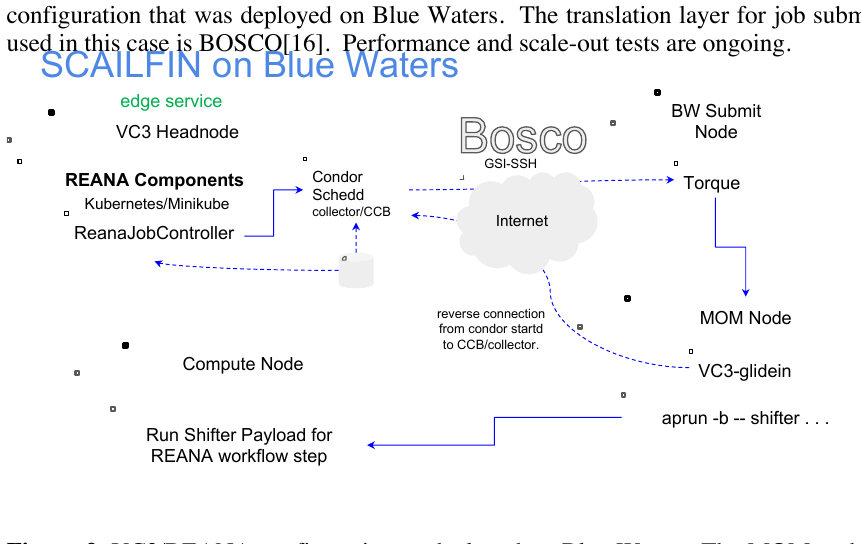
Figure 3 . VC3/REANA configuration as deployed on Blue Waters. The MOM nodes host the local PBS batch system that distributes tasks to the compute